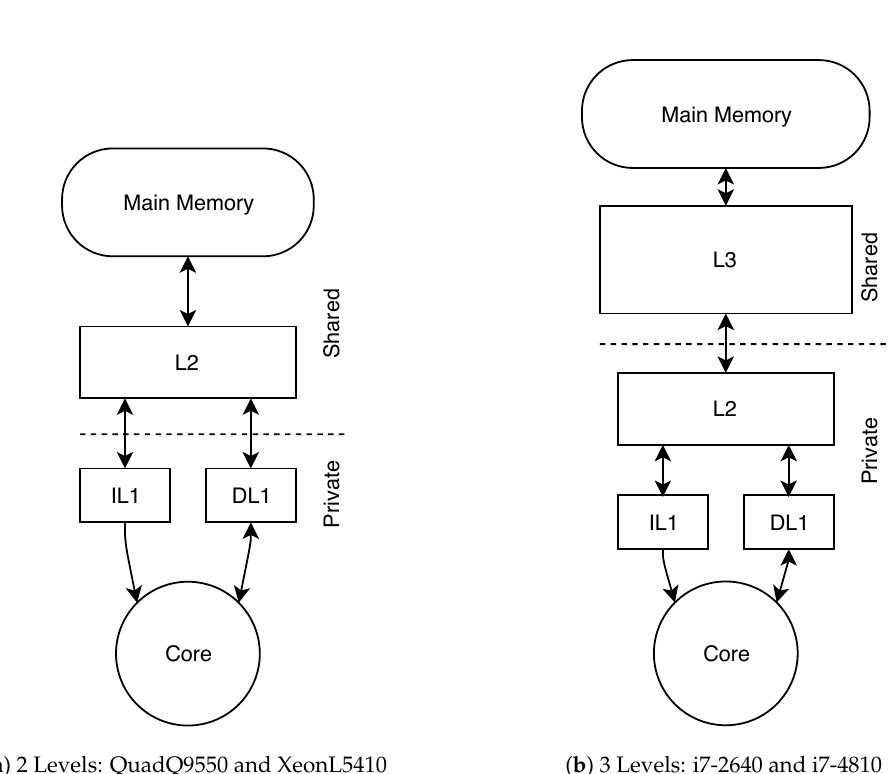
Figure 12. Memory hierarchy